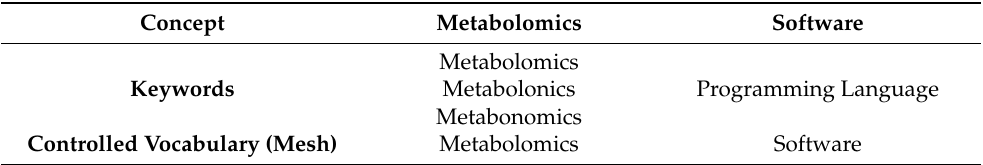
Table 3. Outline of first PubMed query to obtain metabolomics software tools papers based on metabolomics and software-related keywords and MeSH